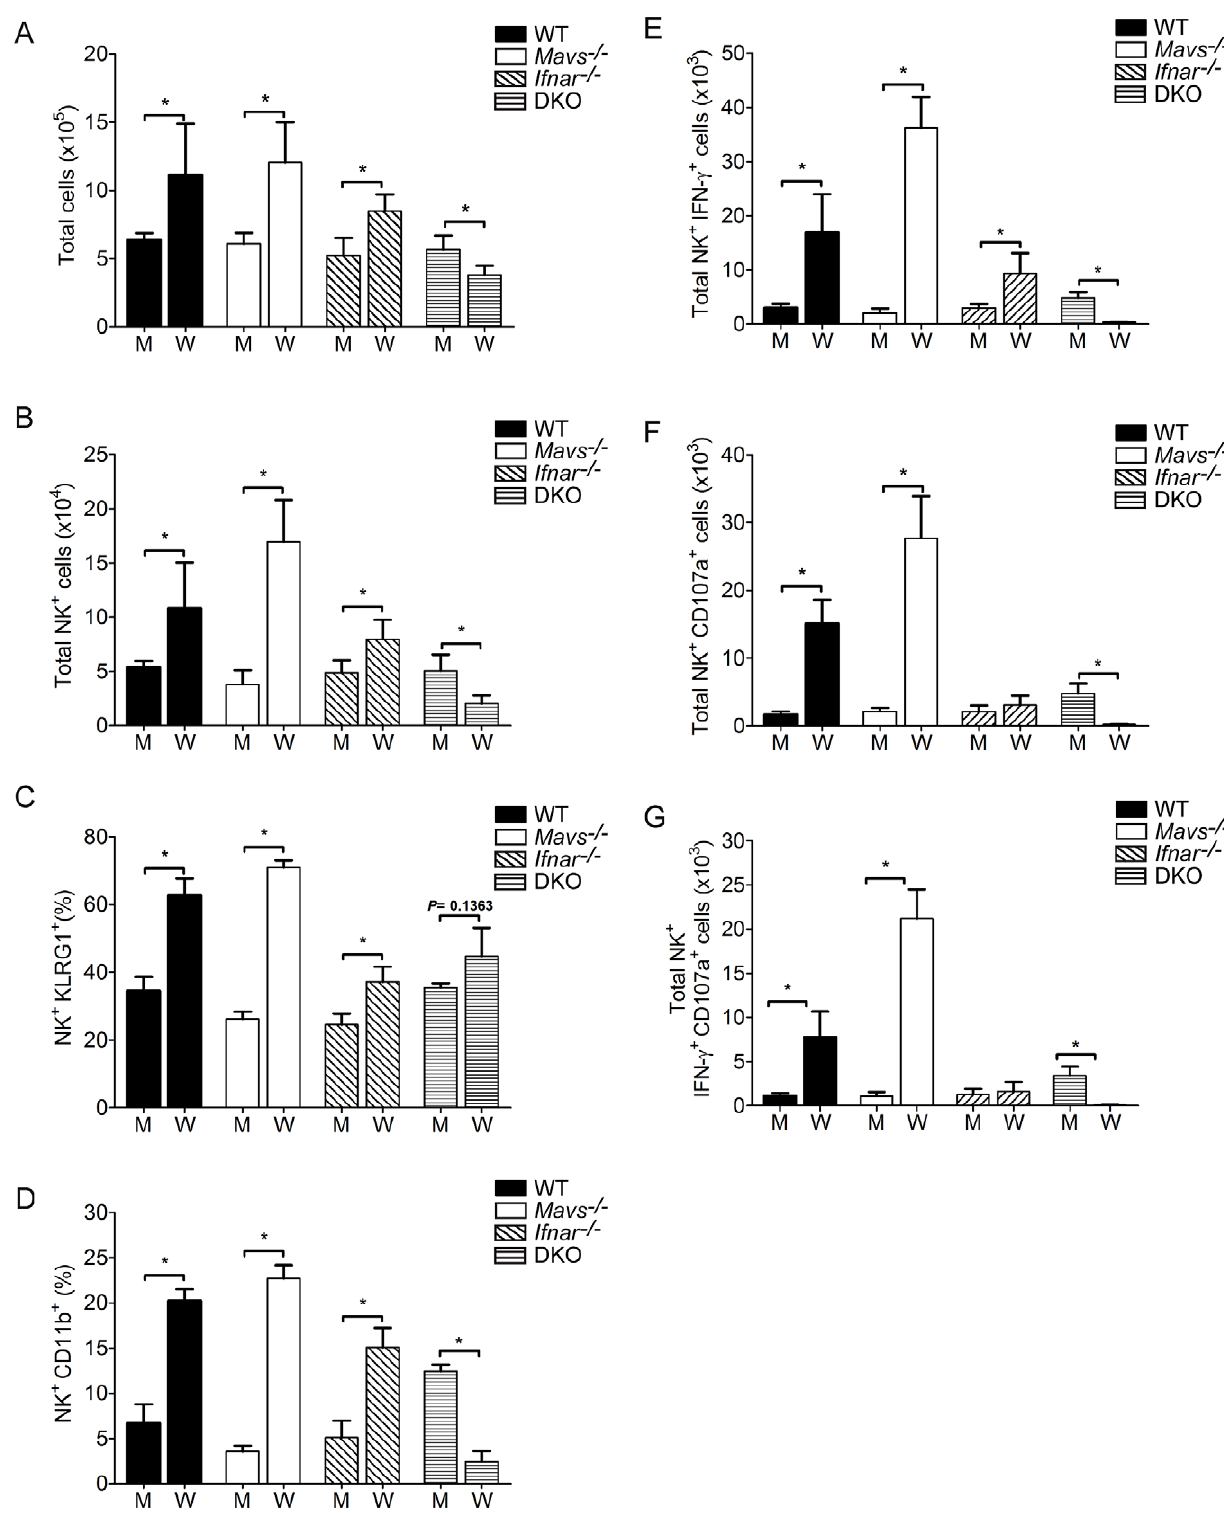
Figure 7. NK cells expand and are functionally active from livers from WT infected mice. WT and DKO mice were mock-infected or infected with WNV-TX. Livers were harvested on day 4 p.i. and immune cells were isolated and characterized by flow cytometry. ( A ) Total cells ( B ) Total number of NK cells (CD3 e 2 NK1.1 + ), ( C ) Percent KLRG1 + NK cells, ( D ) Percent CD11b + NK cells, ( E ) Total number of IFN- c + NK cells, ( F ) Total number of CD107a + NK cells, ( G ) Total number of IFN- c + CD107a + NK cells. Graphs show the mean + / 2 standard deviation (n=4). Asterisks denote P , 0.05. The data are representative of two or more independent experiments.